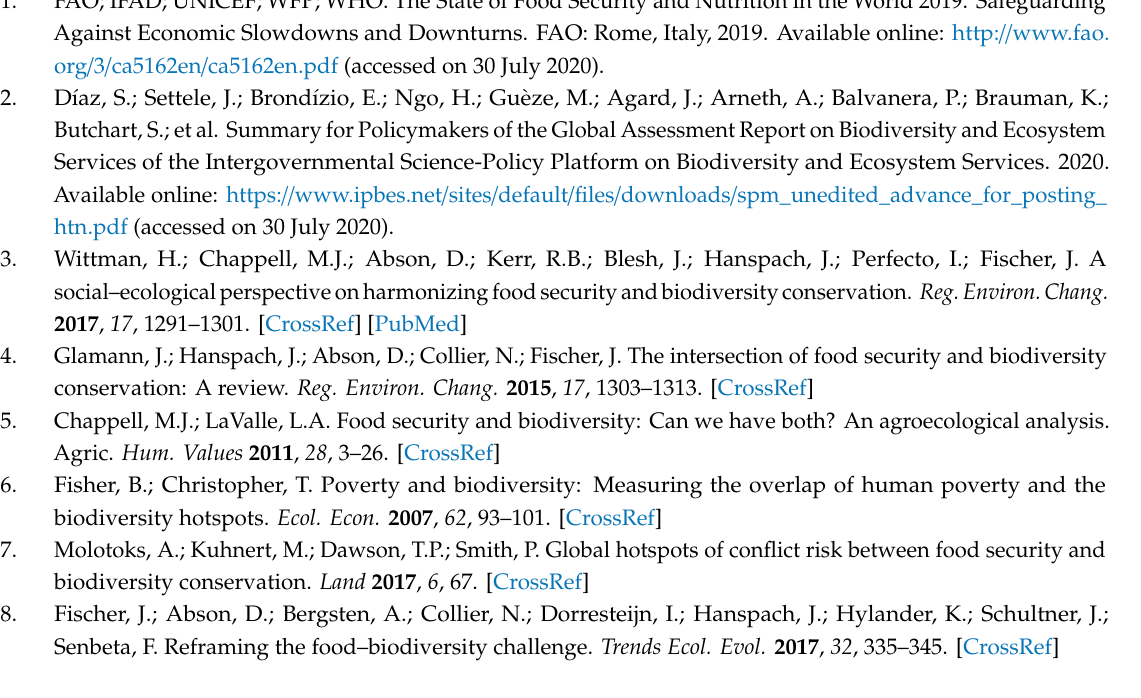
Table S1: The bibliographic information for the studies included in this